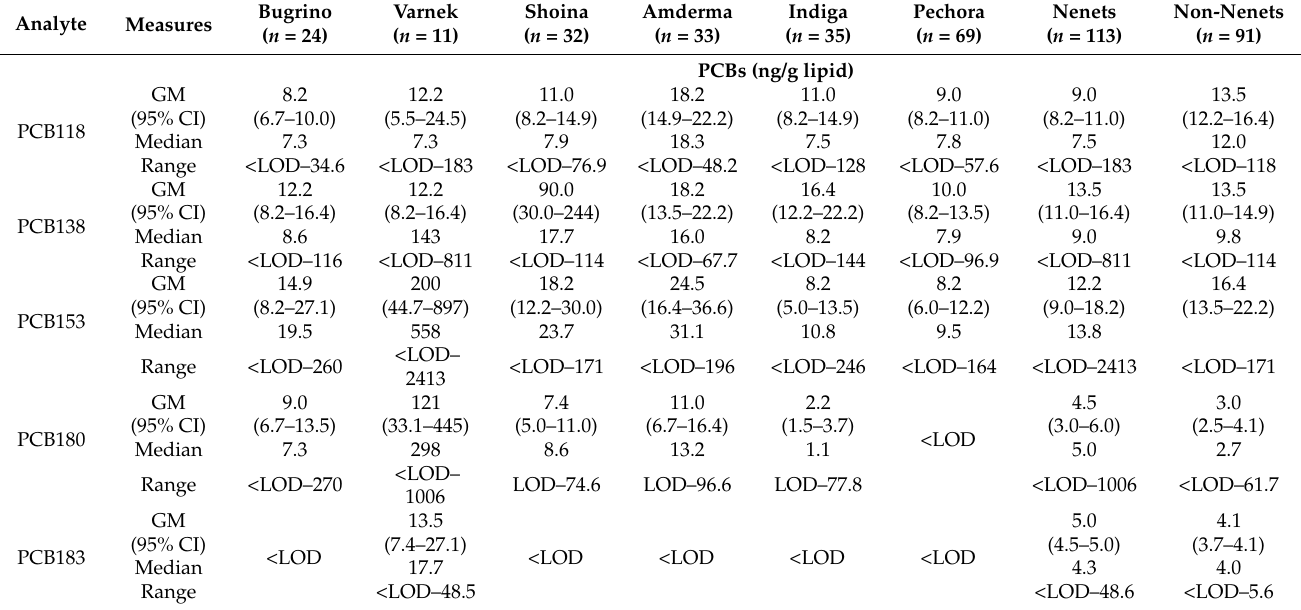
Table 3. Serum concentrations of polychlorinated biphenyls (PCBs) and organochlorine (OC)